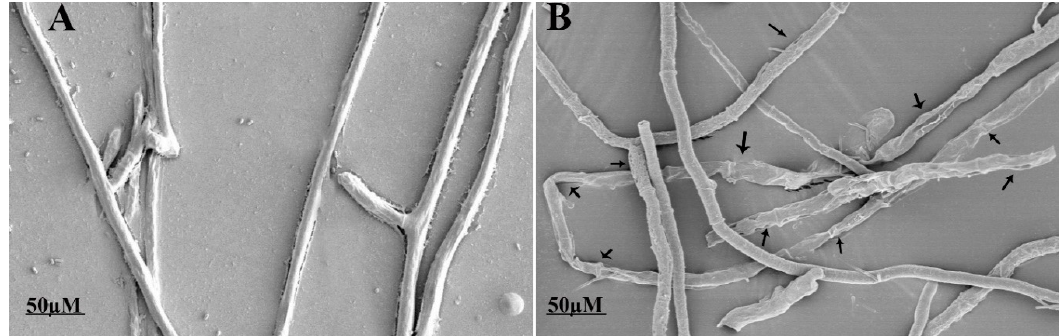
Figure 4. E ff ect of fengycin on the morphology of S. sclerotiorum under a scanning electron microscope: ( A ) control and ( B ) fengycin-treated (20 µ g / mL)